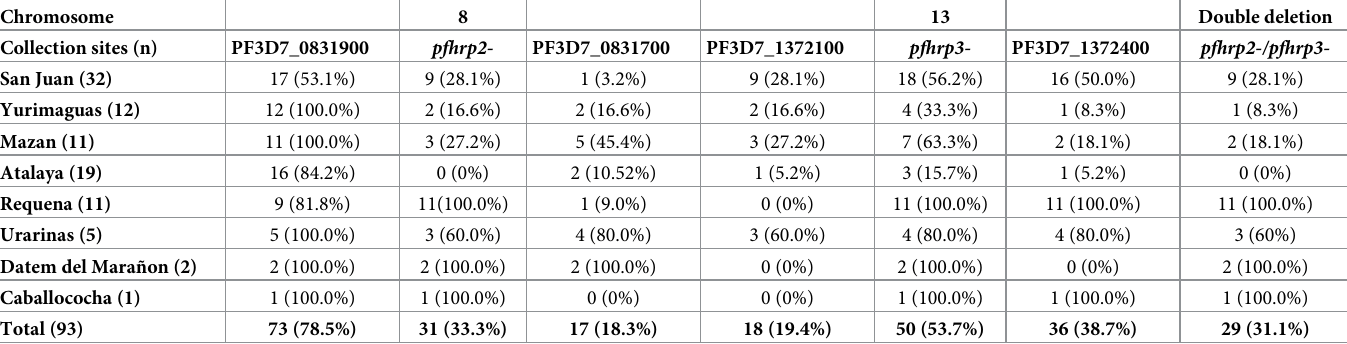
Table 2. Proportion of pfhrp2 , pfhrp3 and flanking gene deletions in samples from different sites of the Peruvian Amazon. Data shows the number (and percentage) of parasites with gene deletions out of total samples tested. Chromosome